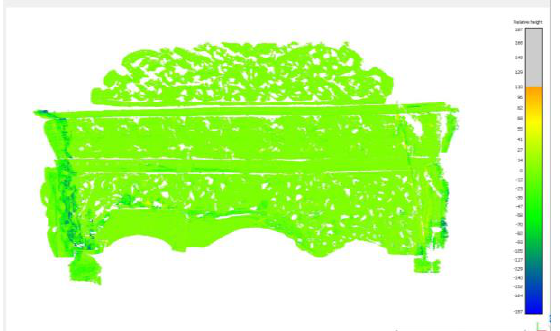
Fig. 6c Mesh-to-mesh volume comparison between the SfM and laser derived surfaces Table 1. Comparison of the two RE models Laser